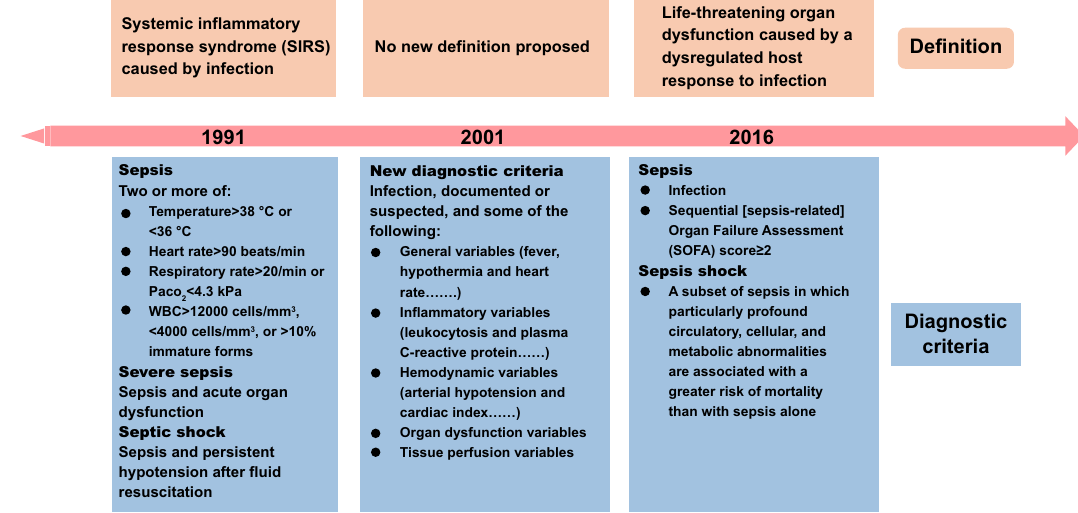
Fig. 1 Definition variation of